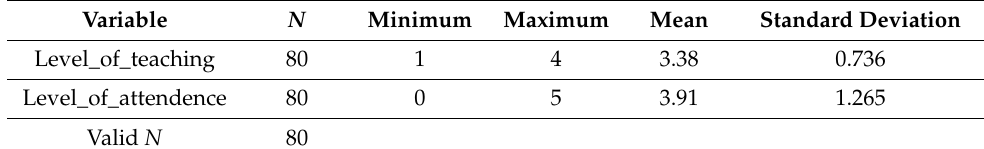
Table 20. Descriptive statistics for the teaching level and the attendance